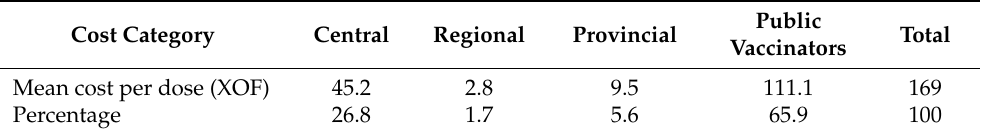
Table 4. Percentage contribution of level distribution to PPR vaccination cost in public distribution channels in Burkina Faso in 2020.